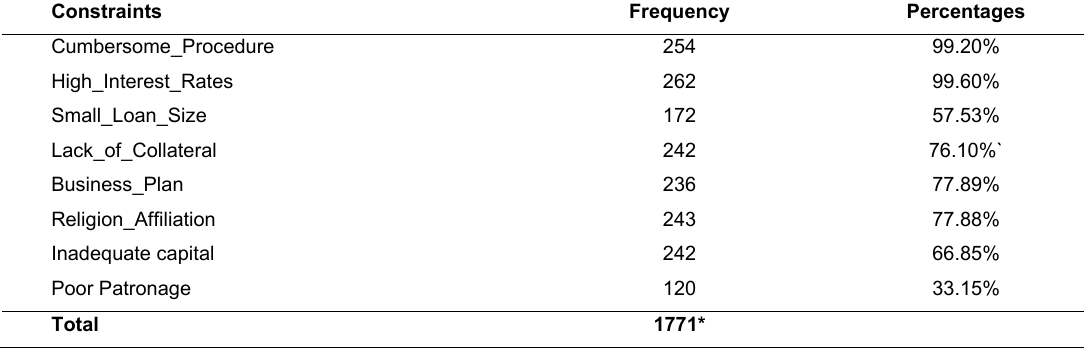
Table 4 analyzes the constraints facing women entrepreneurs in Kano metropolis, Kano State Nigeria. Table 4. Constraints to financial access by women entrepreneurs in Kano